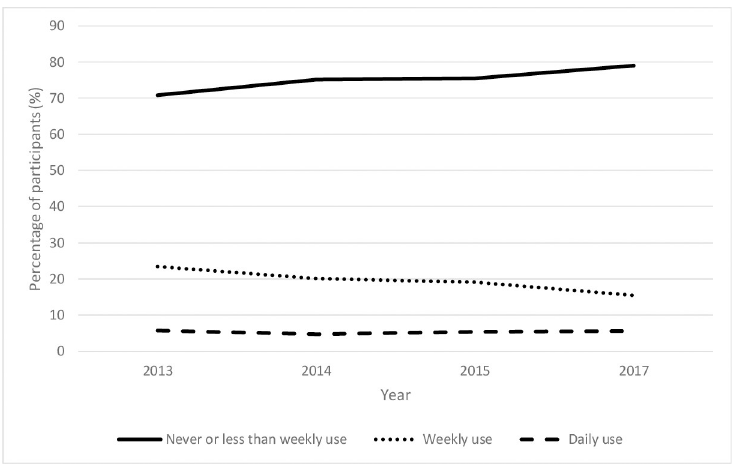
Fig 2. Reported ED consumption between 2013 and